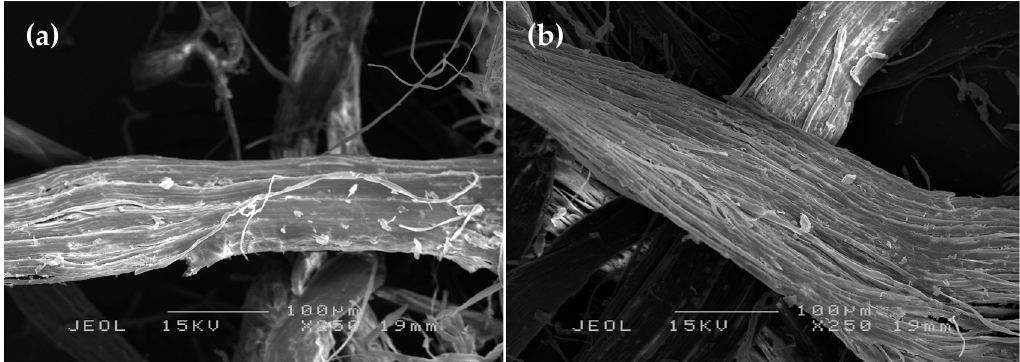
Figure 2. SEM micrographs of ( a ) 250x PALF and ( b ) 250x SHS-PALF.